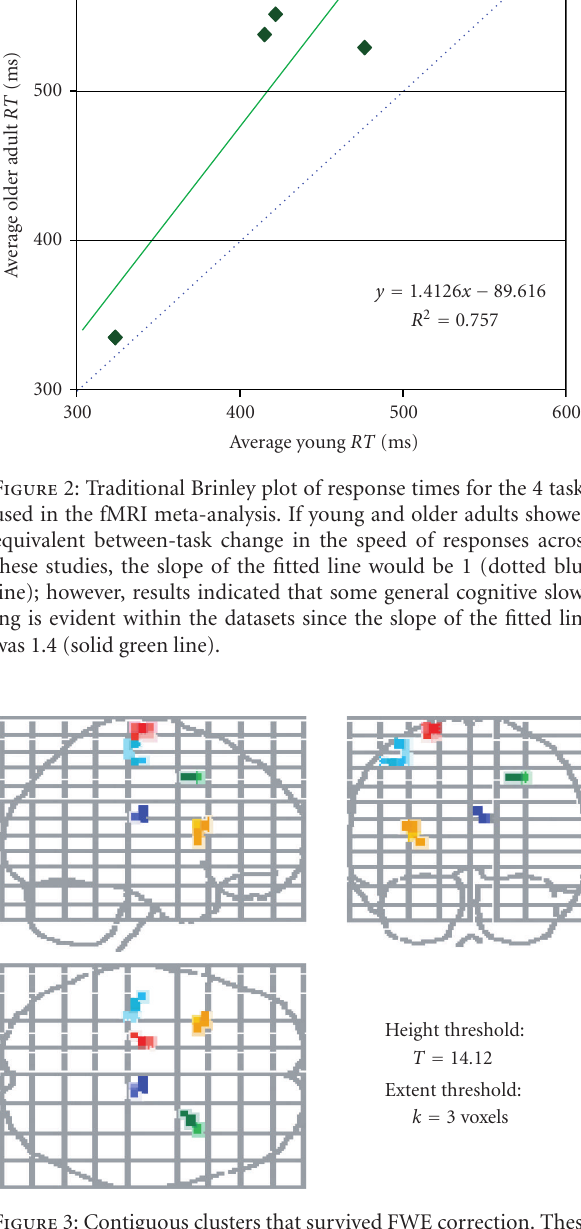
Figure 3: Contiguous clusters that survived FWE correction. These clusters had slopes that were not significantly equal to one (color- coded for clarity), and theoretically, they localized areas of di ff er- ences in between-task BOLD signal change for older and younger